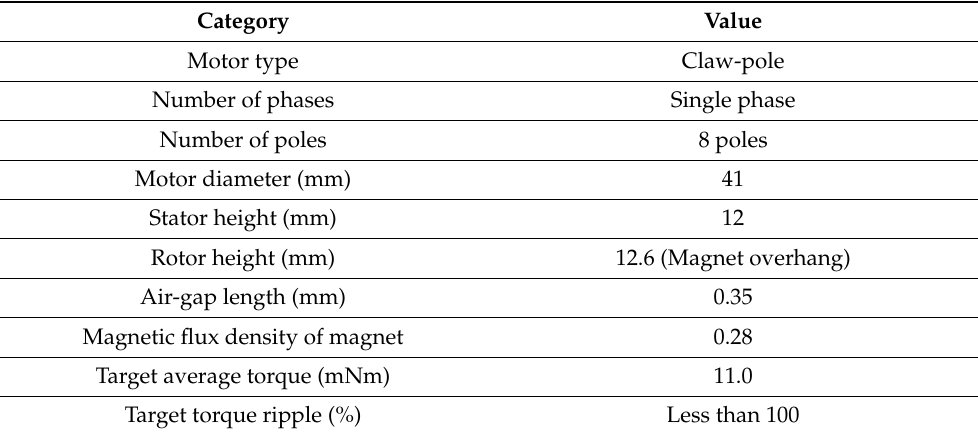
Table 2. Specifications of the target motor.